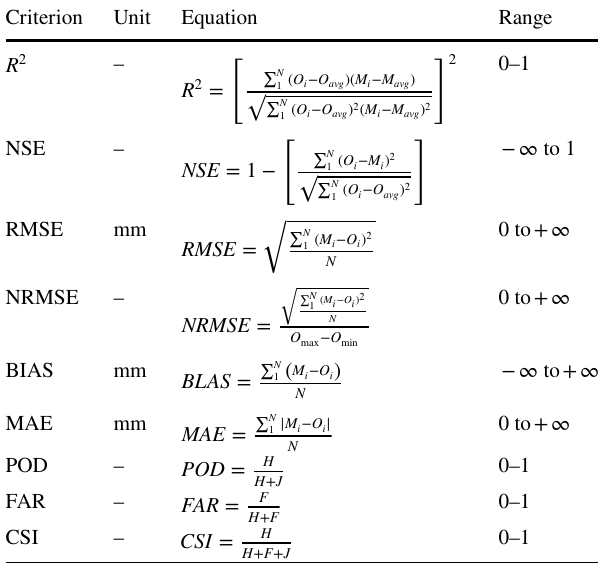
Table 3 The used performance criteria in this study